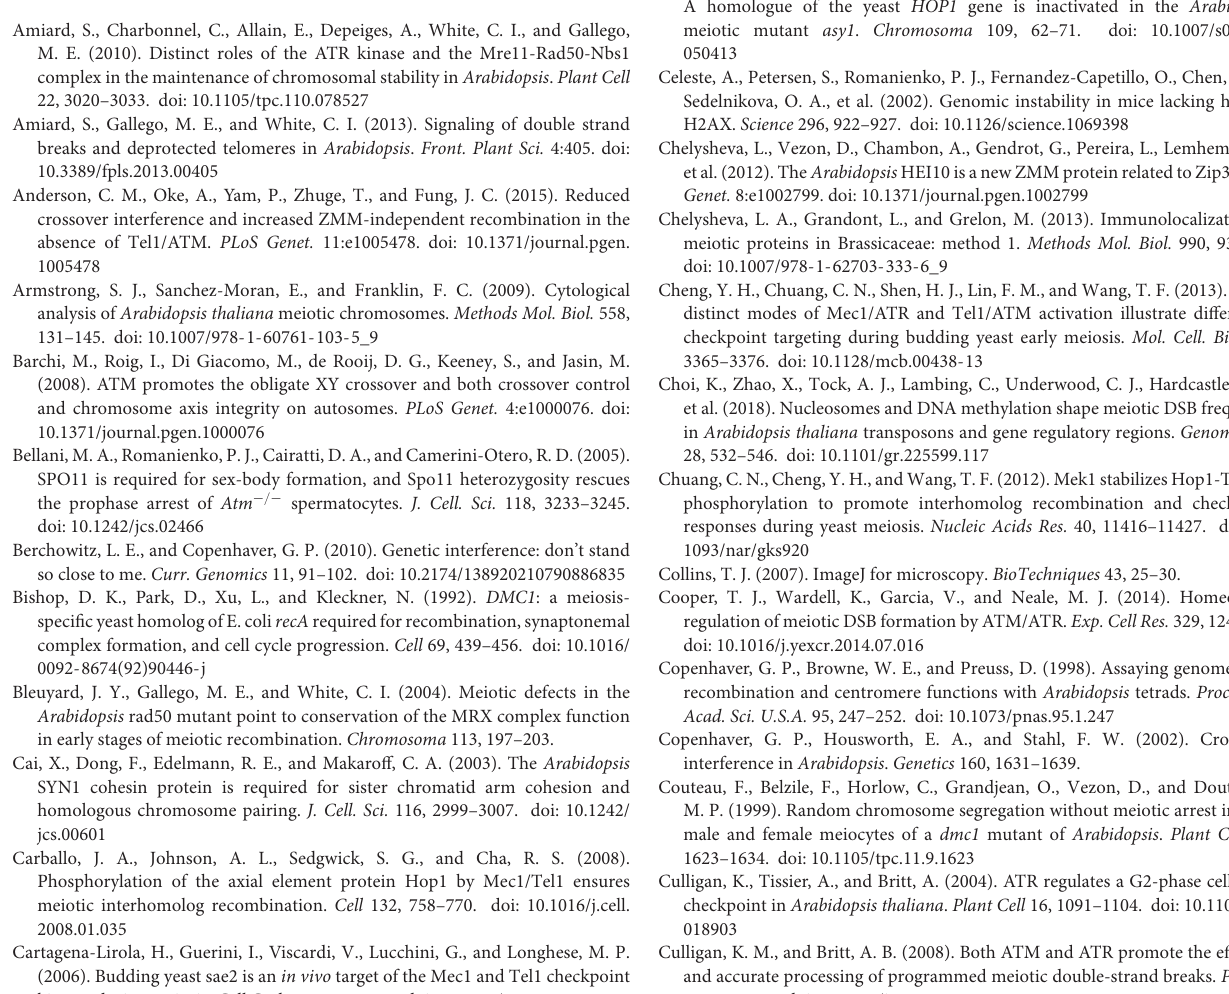
Typical chromosome morphology of each type of metaphase I cells in different mutants exhibited in Figure 7A . TABLE S1 | List of primers used in this study. TABLE S2 | List of SSLP markers primers used in this study. TABLE S3 | Numbers of counted γ H2AX signal foci in each image.